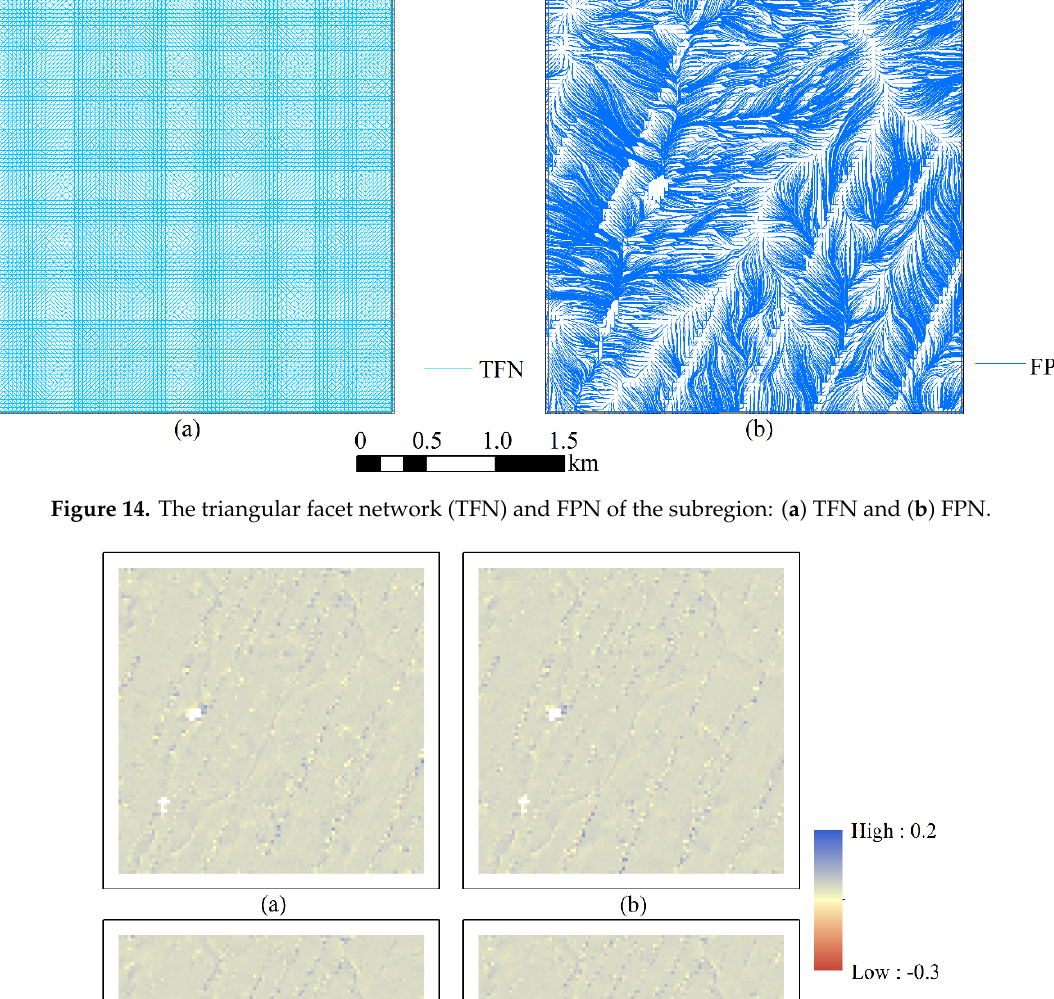
Figure 16. Spatial distribution of the simulated C values of the subregion for the: ( a ) Evans, ( b ) Zevenbergen, ( c ) Shary, and ( d ) FPN-based methods. Experiments were implemented on a notebook computer with an i5-7200U CPU, 8 GB RAM, 980M NVIDIA GeForce GTX, and Microsoft Windows 10 using the 64-bit option. For the E1, G1, and